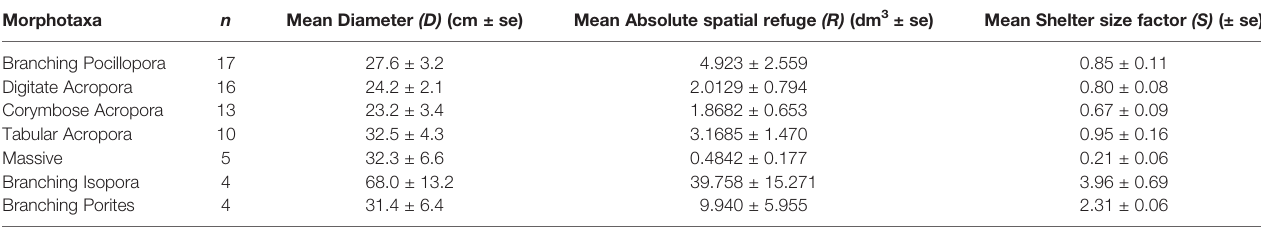
TABLE 3 | Summary of representation and dimensions among the seven unique morphotaxa used for colony reconstructions.